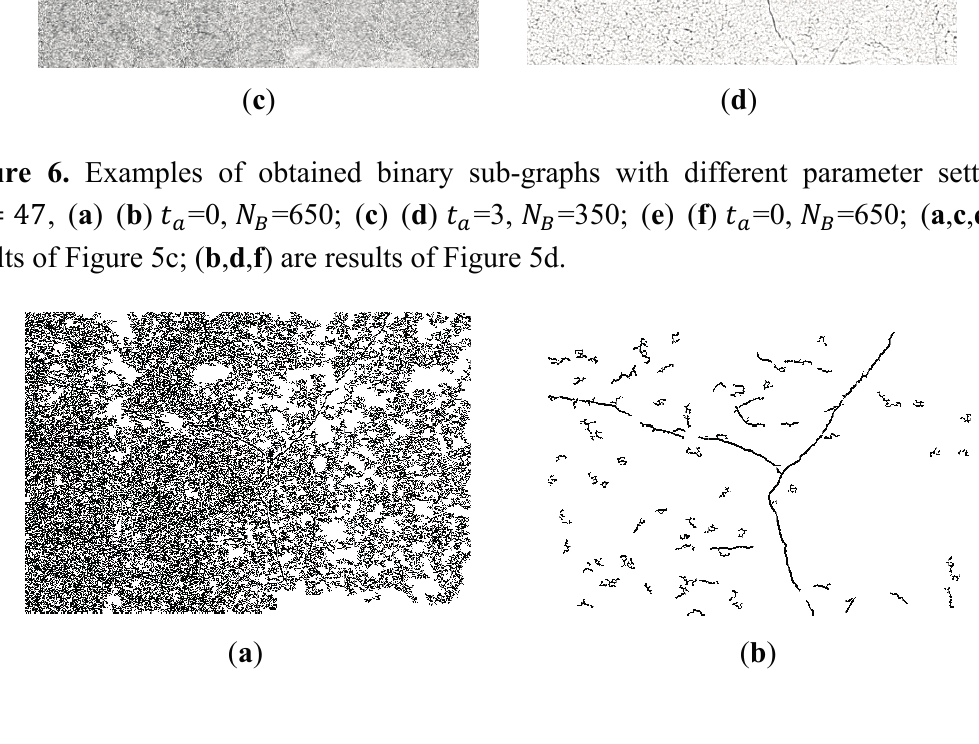
=0, (cid:1840) =650; ( a , c , e ) are (cid:3028) (cid:3003)